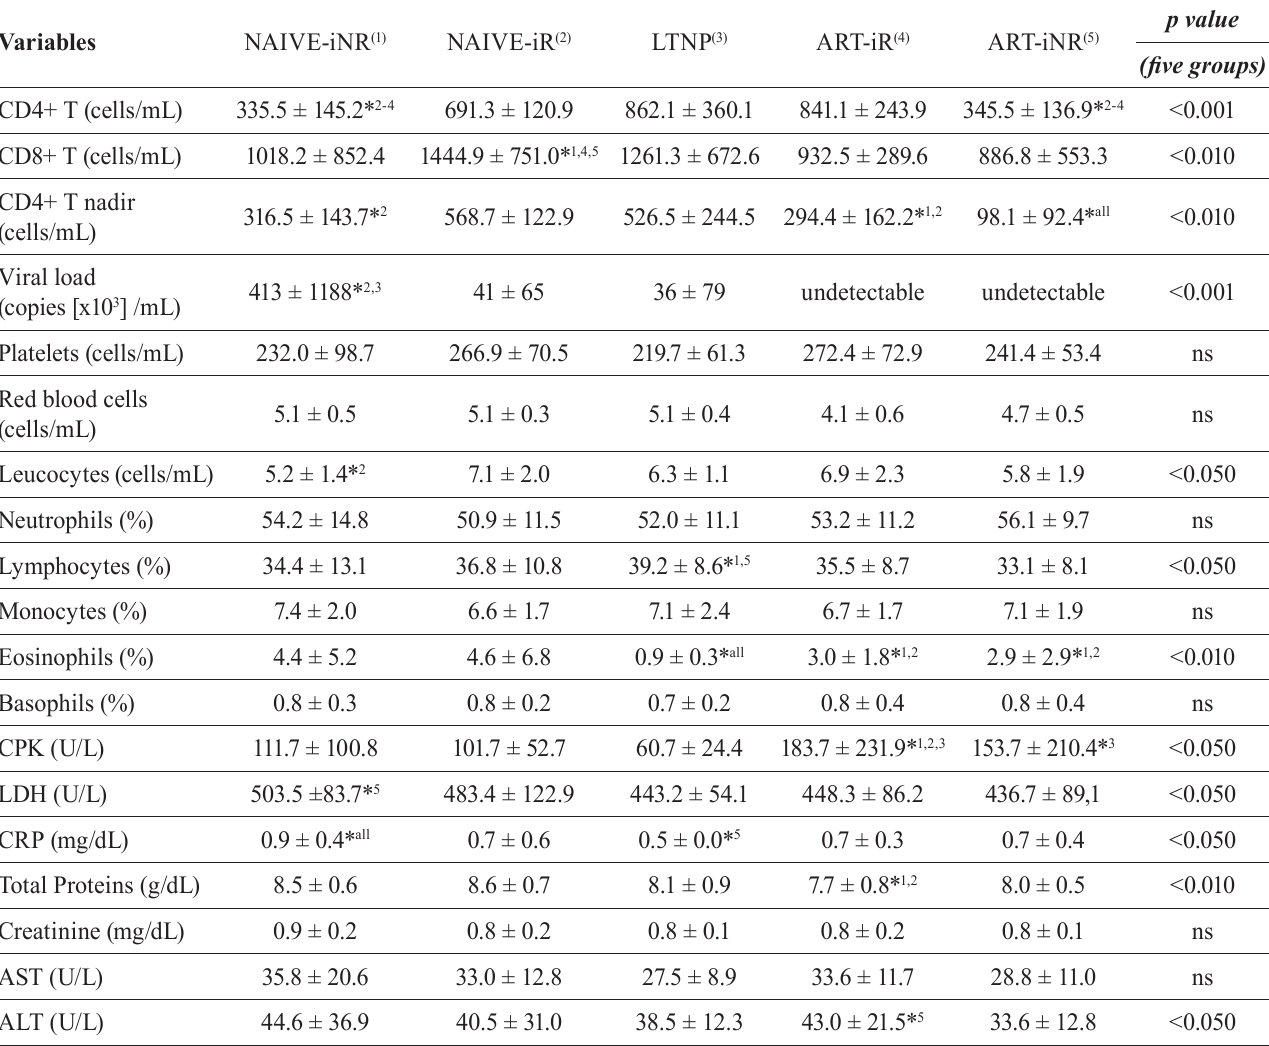
TABLE I - I mmunovirological, hematological and biochemical exams of HIV-infected groups